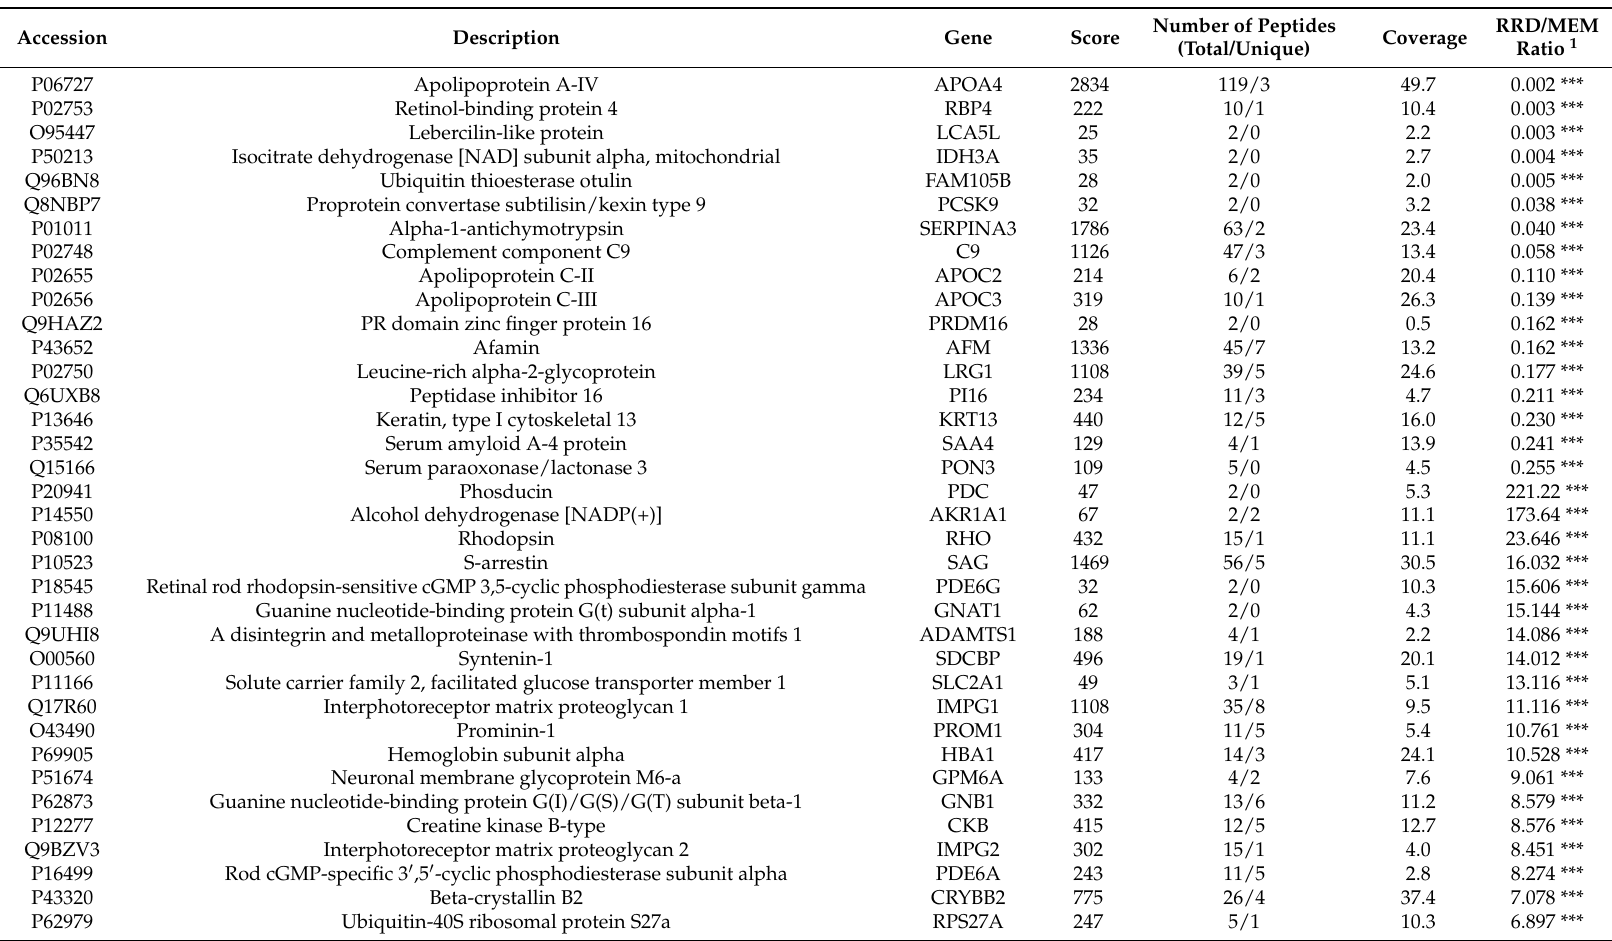
Table 2. List of proteins found differentially expressed in vitreous of patients with rhegmatogenous retinal detachment (RRD) in comparison with macular epiretinal membranes (MEM), with FDR ≈